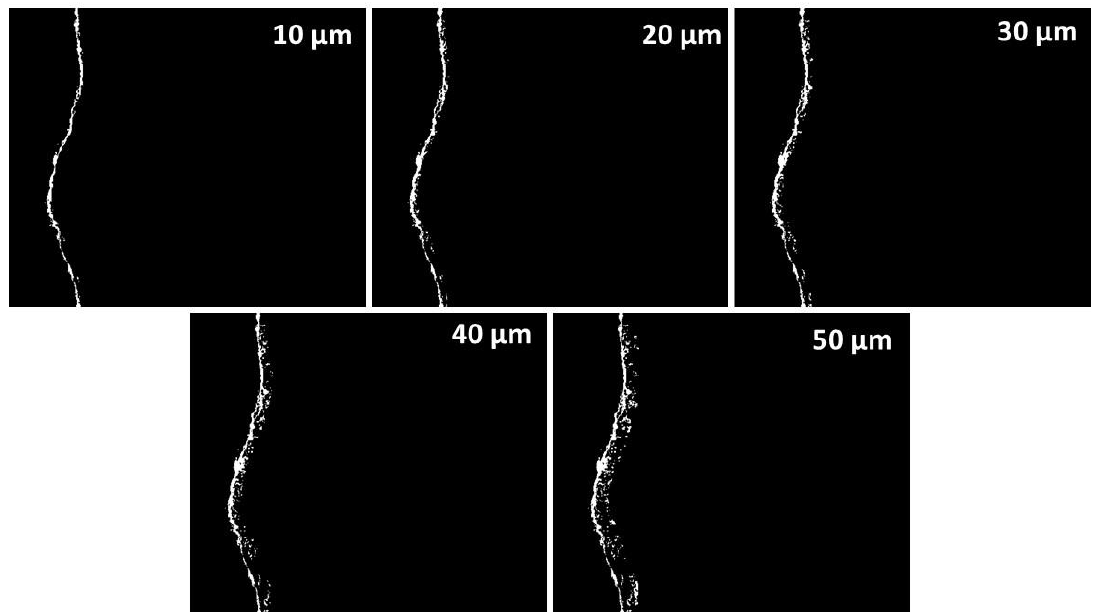
Figure 8. Images resulting from the sectors of the ITZ with the porosities determined at different theoretical thicknesses.